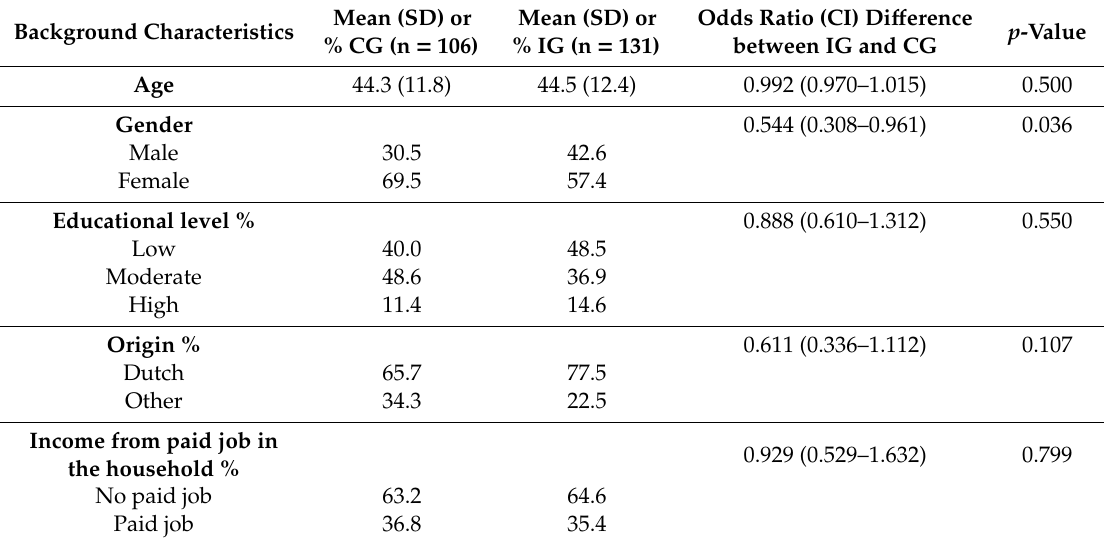
Table 2. Background characteristics and di ff erences between participants in the intervention group (IG) and control group (CG) at baseline (N =